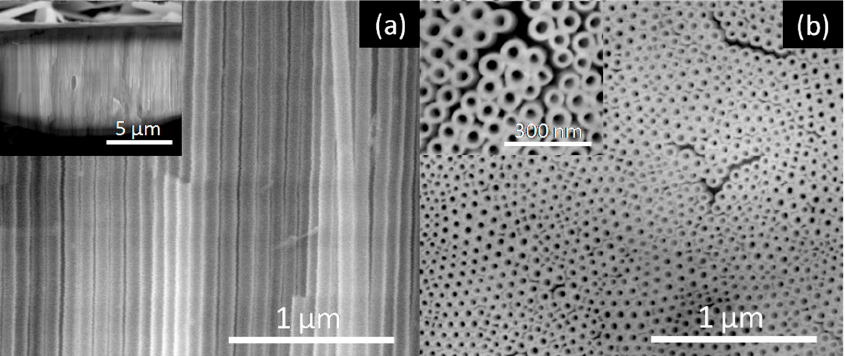
Figure 5. SEM images of the nanoporous AHO templates after 1 h of anodization for the FA sample: ( a ) Cross-section view (inset at lower magnification) and ( b ) top-view (inset at higher magnification).